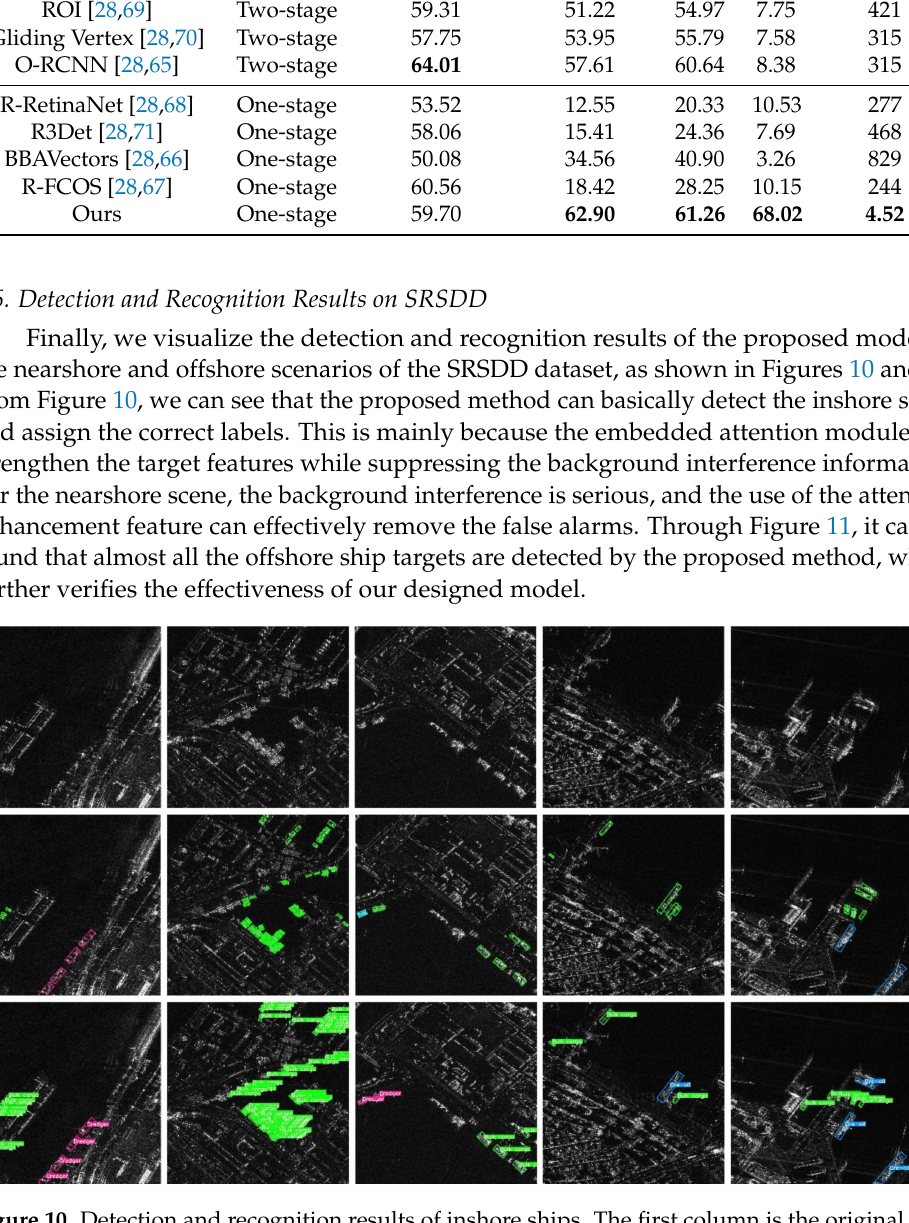
Figure 10. Detection and recognition results of inshore ships. The first column is the original SAR images, the second column is the ground truth, and the third column is our